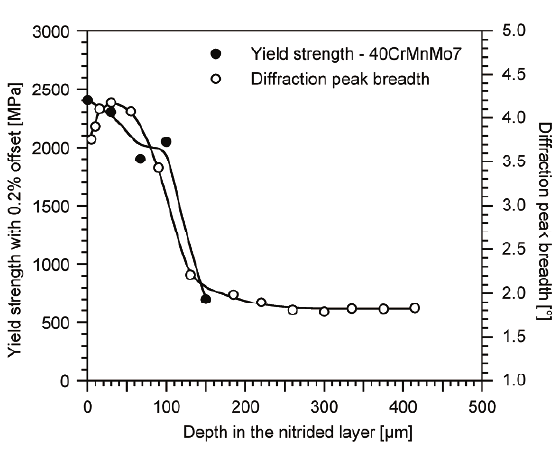
Figure 5 – In-depth residual stress profile in the nitrided steels. Figure 6 – In-depth yield strength and X-ray diffraction peak breadth in the DIN 40 Cr Mn Mo 7 steel.